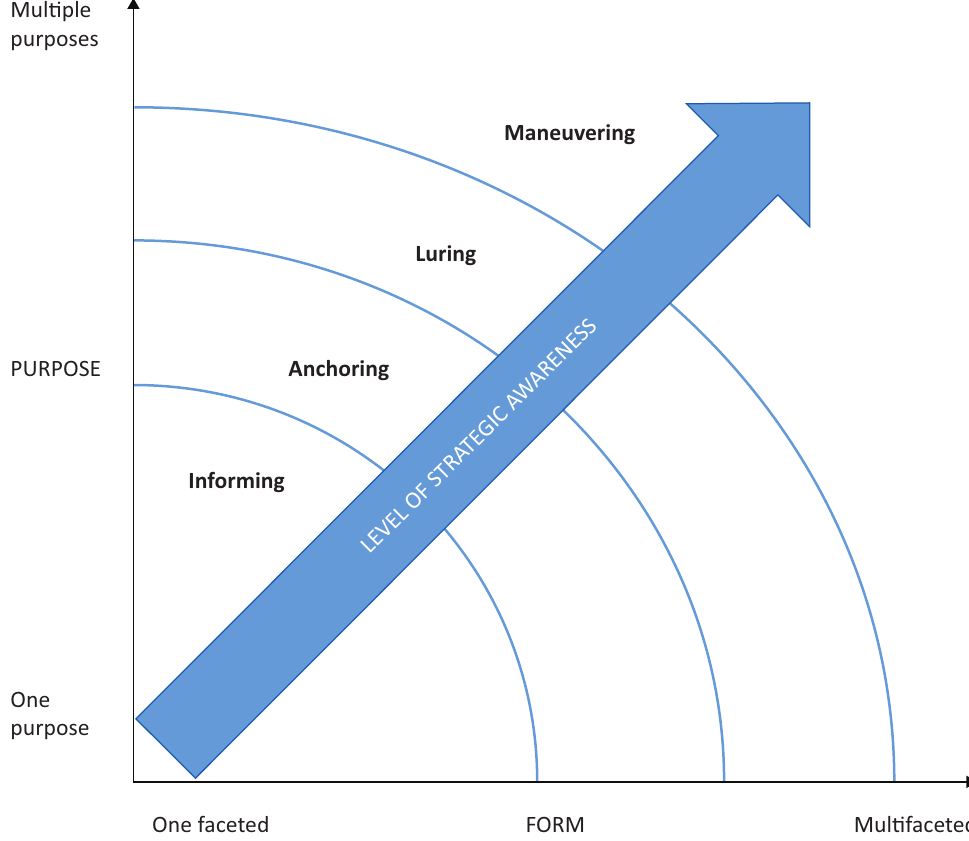
Figure 5. The relationship between digital academic discourse practices and strategic